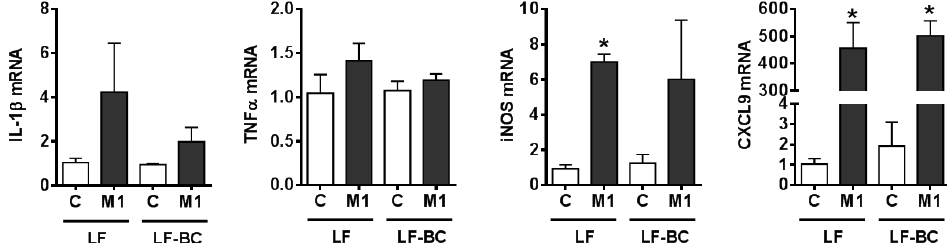
Figure 6. Expression of M1 marker genes in mouse bone marrow-derived macrophages (BMDM) treated with serum from mice fed a low fat control (LF) or a LF with blackcurrant (LF-BC, LF supplemented with 6% of freeze-dried whole blackcurrant powder by weight) for one week ( n = 7 per group). Serum samples from two or three mice were pooled and BMDM were polarized into M1 using interferon γ (IFN γ ) and tumor necrosis factor α (TNF α ) (10 ng / mL each) for 24 h in the presence of 15% mouse serum. Data are shown as mean ± SEM. *, p < 0.05 vs. respective